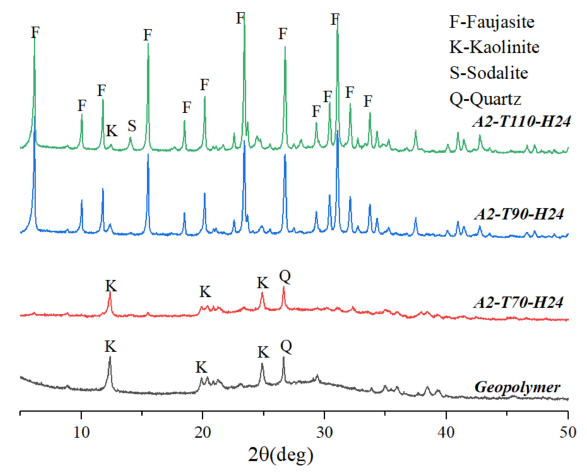
Figure 3. XRD patterns of samples synthesized at di ff erent hydrothermal temperature.